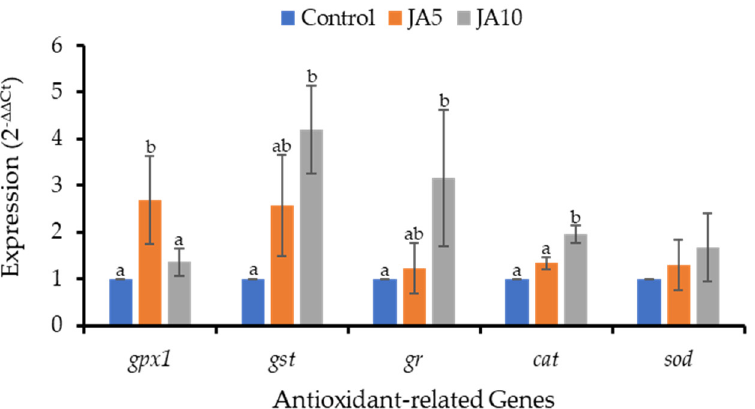
Figure 2. Relative expression of gpx1, gst, gr, cat, and sod in the liver of red tilapia fed experimental diets for 4 weeks. Results are means ± SD ( n = 6). a, b Different superscript letters in each gene denote statistically significant differences between experimental diets ( p < 0.05). JA5: 5.0 g/kg JA-supplemented diet; JA10: 10.0 g/kg JA-supplemented diet.